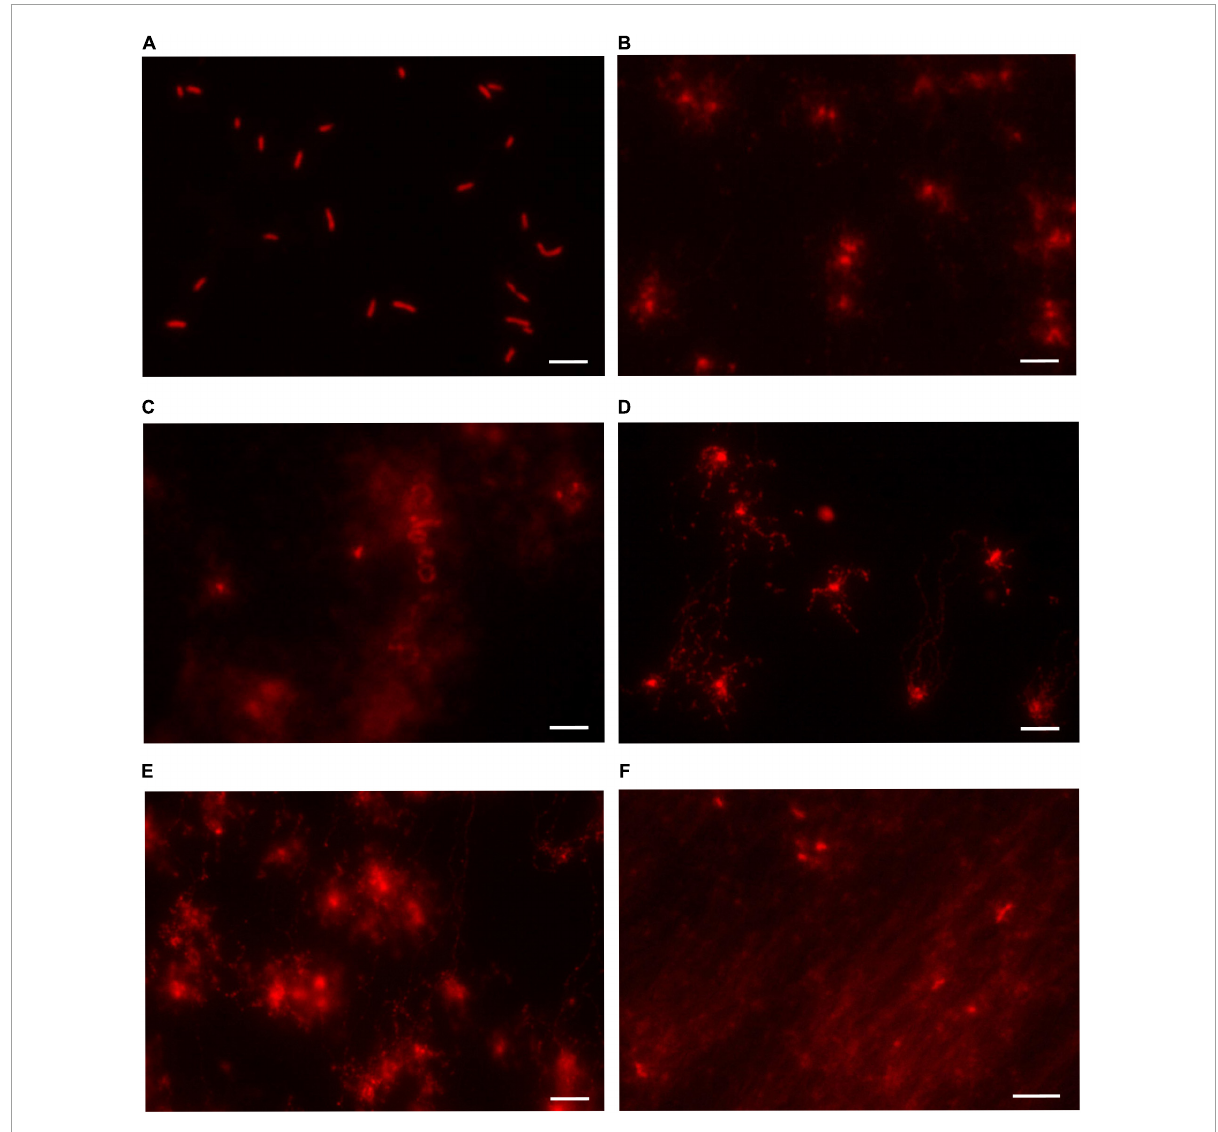
FIGURE4 DNA integrity analysis in Thermus thermophilus mutants. Representative images of control and mutant strains analyzed by neutral comet assay and stained with GelRed R (cid:13) . The whole extent of the comet tail relative to the head provides qualitative information about the amount of DNA lesions (A) HB27. (B) ppol::kat . (C) addAB::kat . (D) ppol_cat . (E) ppol::lox72 . (F) ppol_comp . In the HB27 cultures, the majority of the cells were intact showing little or no DNA migration (fluorescence limited to nucleoids). On the other hand, in the mutants DNA leaked out from the nucleoid indicating the presence of strand fragmentation. The different halos and migration patterns are indicative of the amount of DNA damage. Cells with extensive lesions had almost all DNA in the tail due to migration from the